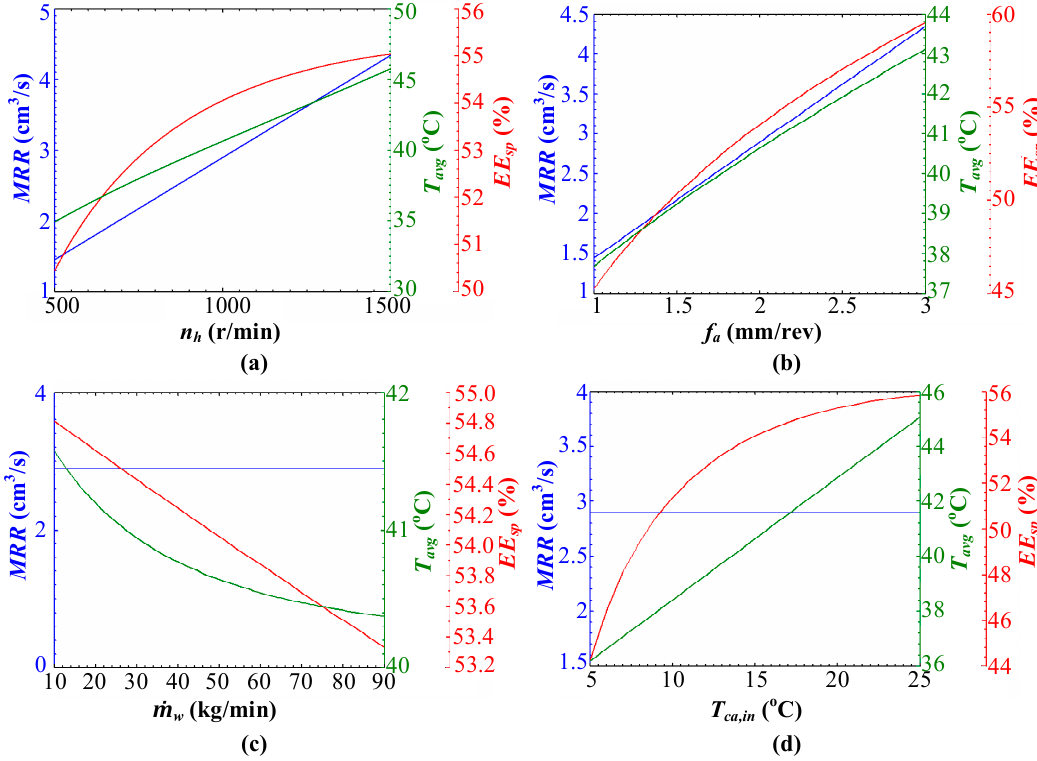
Figure 8. Effects of: ( a ) spindle speed, ( b ) feed rate, ( c ) cooling water flow rate, and ( d ) compressed air temperature on EE sp , MRR , and T avg .